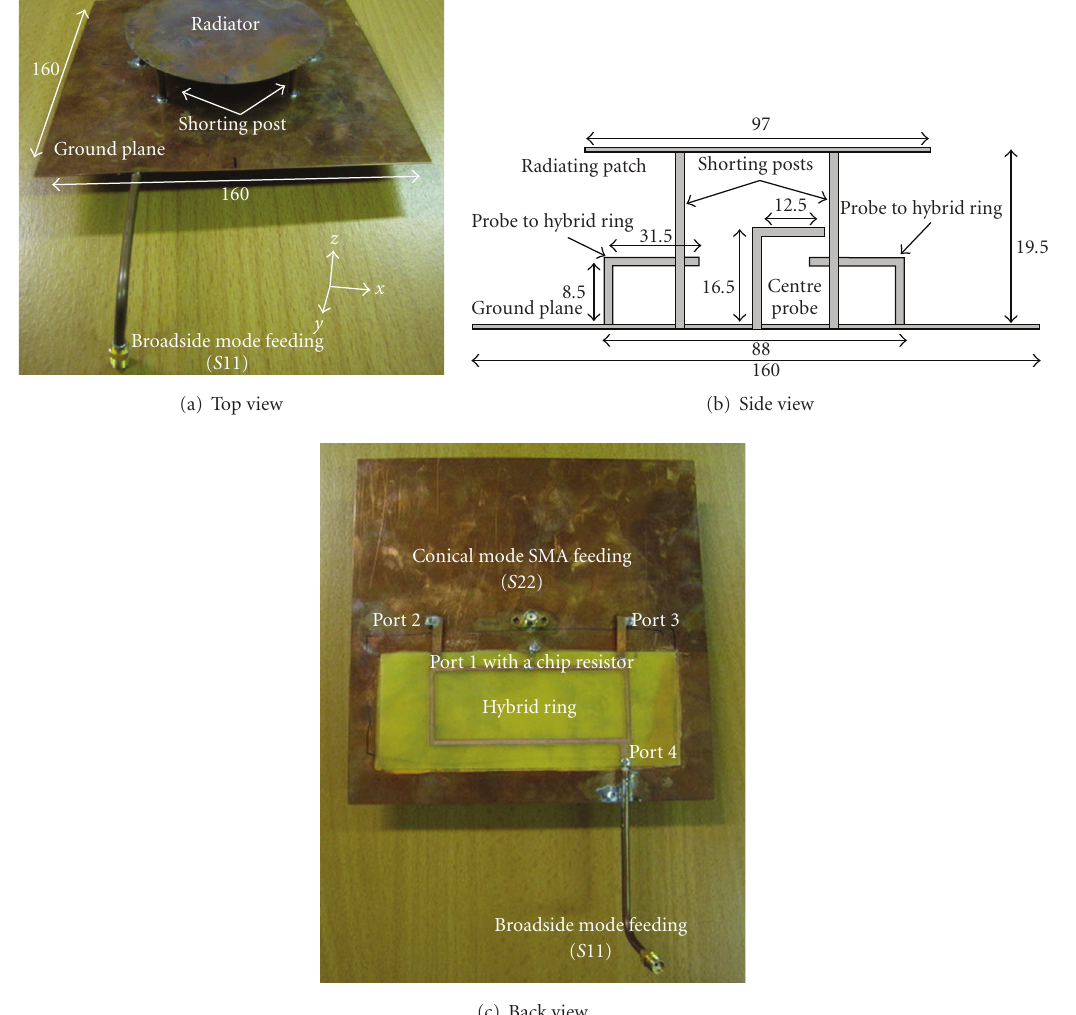
Figure 1: Geometry of the proposed diversity antenna (Design 1): (a) top view, (b) side view, and (c) back view (Units in